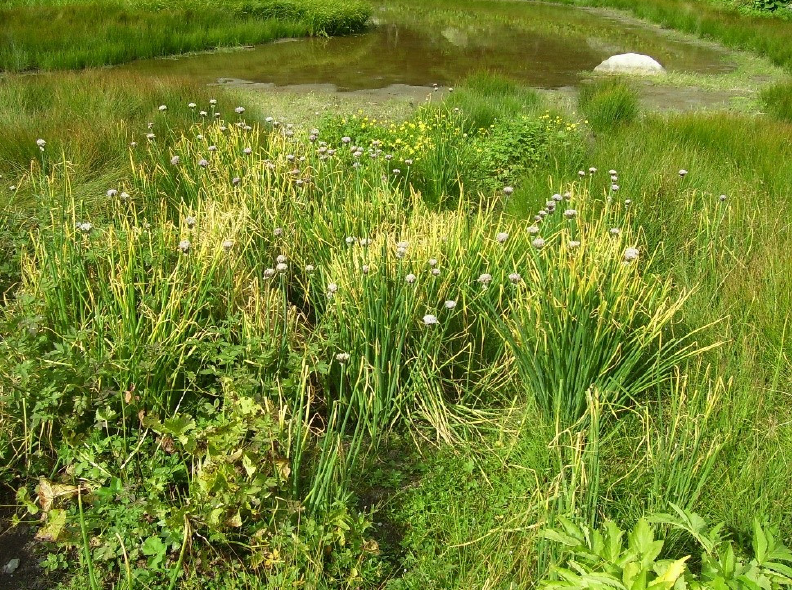
Figure 3. Plants of A. ledebourianum on the ridges of Western Altai (August 2020) (photo by N. Prem- ina).